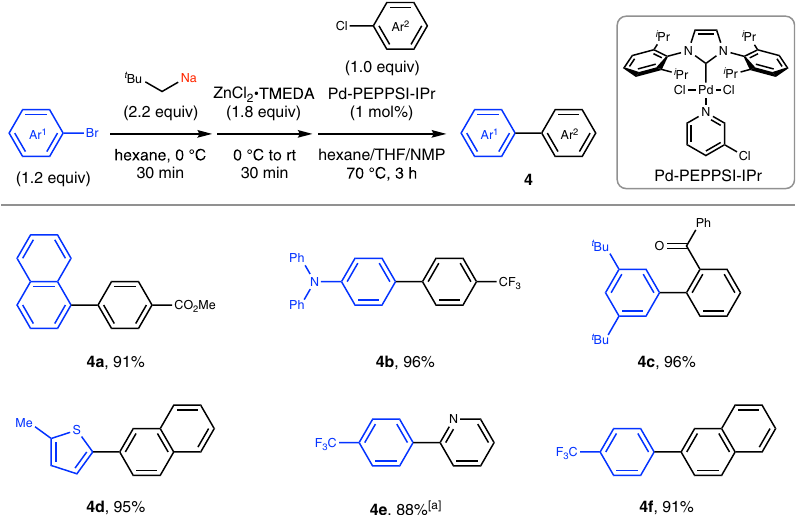
Fig. 5 Palladium-catalyzed Negishi cross-coupling reactions using arylsodiums. Conditions: step 1, neopentyl chloride (220 mol%) and SD (450 mol%) in hexane (2.0 mL) at 0 °C, 20 min; step 2, Ar 1 Br (1.2 equiv) was added at 0 °C, 30 min; step 3, ZnCl 2 • TMEDA (1.8 equiv) was added at 0 °C, stirred at RT for 30 min; step 4, Pd-PEPPSI-IPr (1 mol%), Ar 2 Cl (0.30 mmol, 1.0 equiv), THF (0.80 mL), and N -methylpyrrolidone (NMP, 0.40 mL) were added and the cross-coupling reaction was performed at 70 °C for 3 h. Yields determined by isolation are shown. a ZnCl 2 • TMEDA (2.2 equiv). SD sodium dispersion, Ar aryl, t Bu tert -butyl, TMEDA N , N , N ’ , N ’ -tetramethylethylenediamine, THF tetrahydrofuran, NMP N -methyl-2-pyrrolidone, i Pr isopropyl, Me methyl, Ph